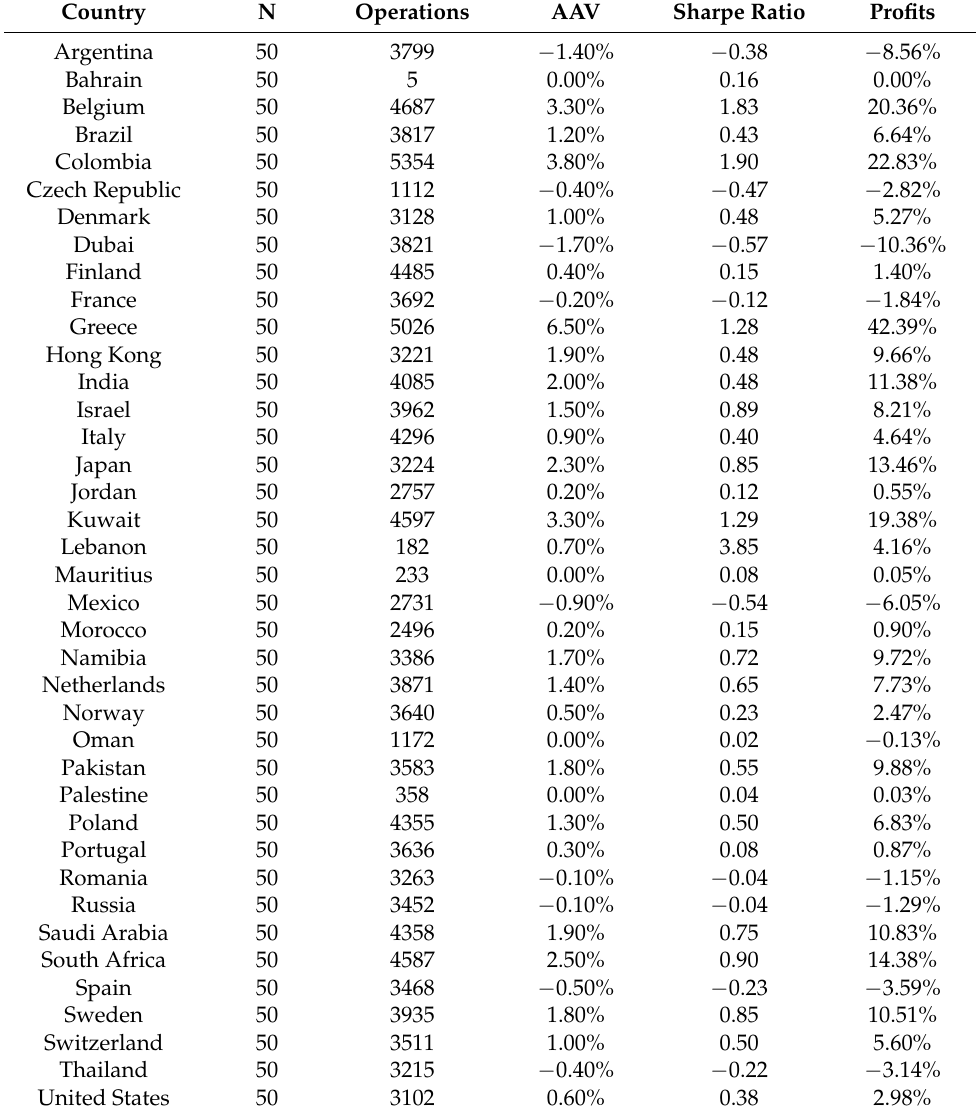
Table A10. Results obtained for the period 2014–2020 (50 Pairs), where N is the number of pairs; AAV Average annualized return; and Profit is the profitability for the full period with transaction